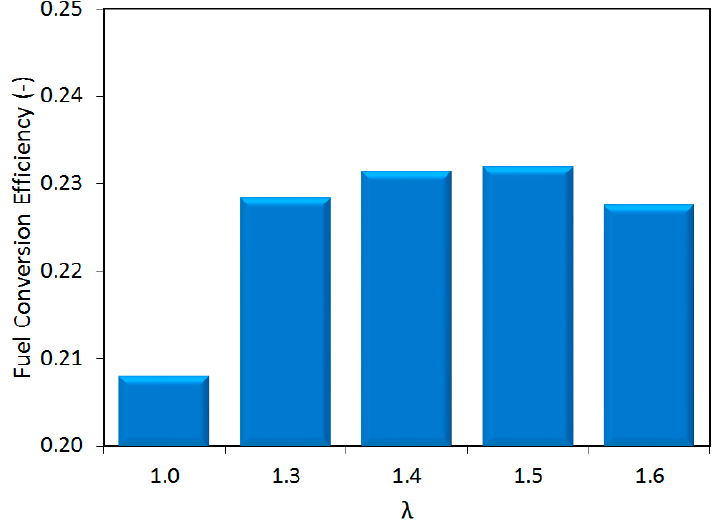
Figure 5. Fuel conversion efficiency evaluated on 200 consecutive engine cycles for different air fuel ratios.